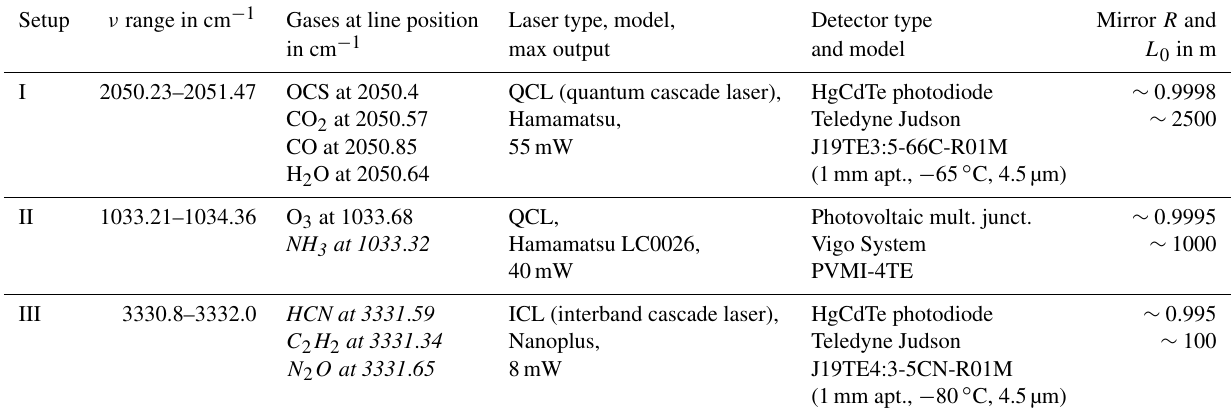
Table 3. Currently implemented ICOS cavity configurations. Each measurement setup consisting of laser and driver board, dielectric mirror, and detector can be used in either one of the two cavity positions in AMICA. Molecules for which sensitivity is too low to measure typical atmospheric mixing ratios in the current setup are shown in italic